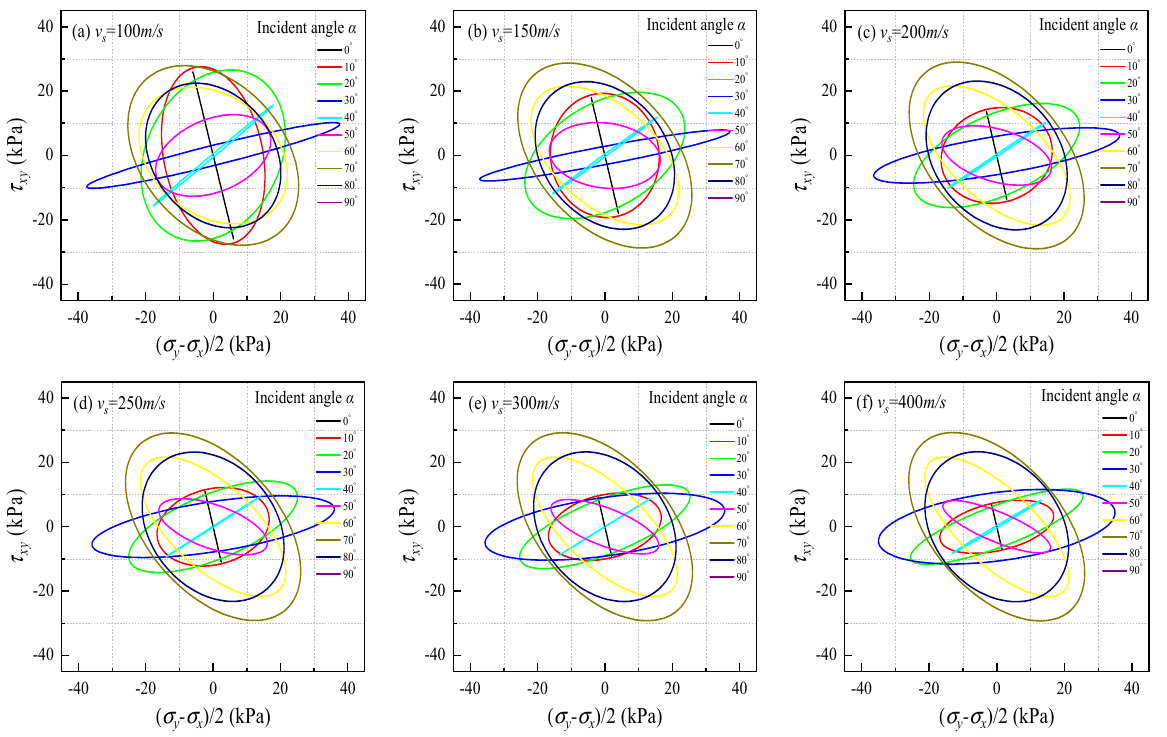
Figure 9. Variation of characteristic parameters of elliptical stress path with the incidence angle for various wave velocity.